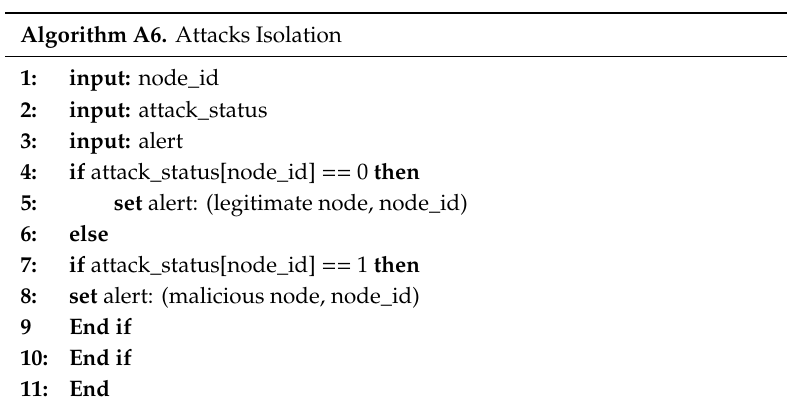
Algorithm A6. Attacks